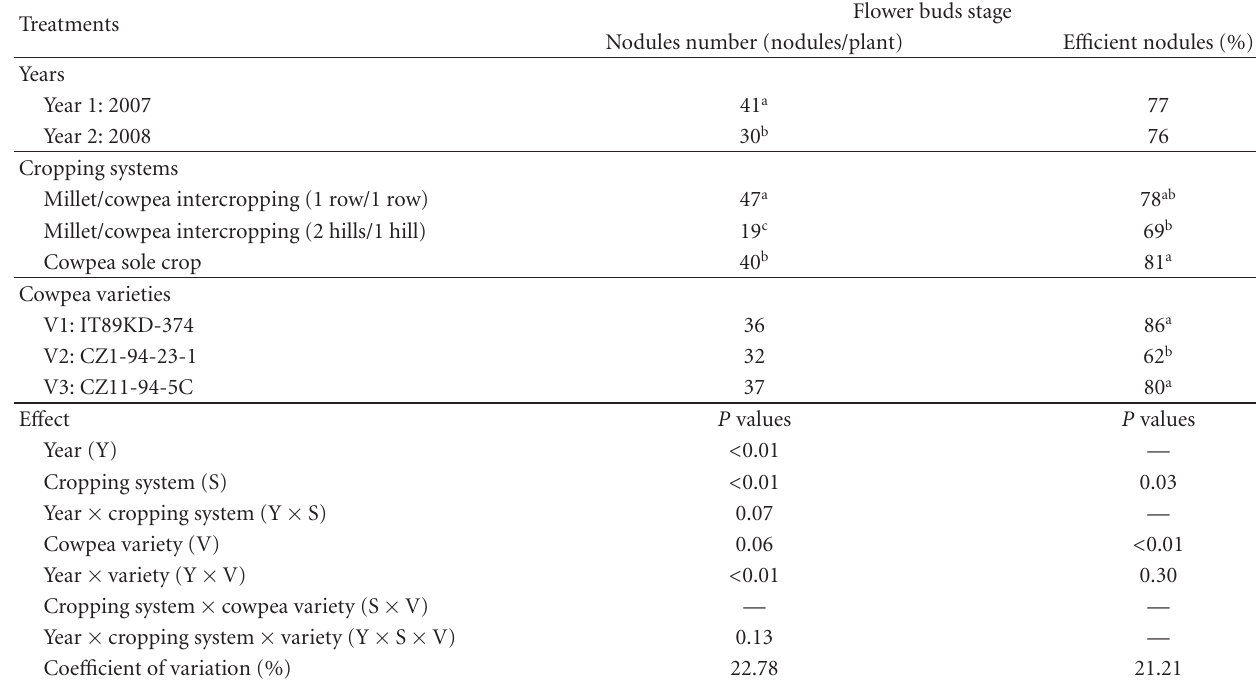
Table 1: Cowpea nodules number (nodules/plant) and e ffi ciency as a ff ected by cropping system and cowpea variety at flower buds stage at Cinzana Agronomic Research Station, 2007 and 2008.